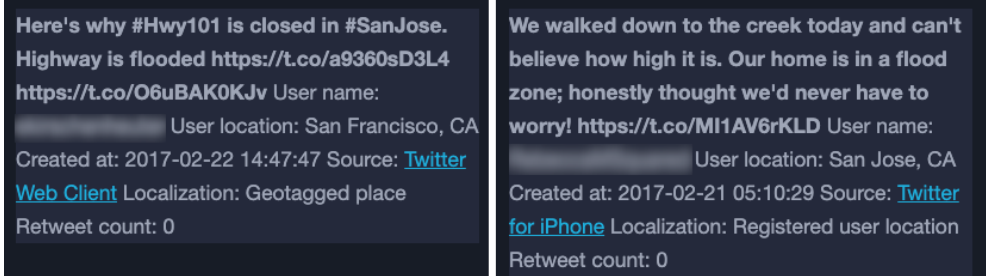
Figure 13. Hydrograph of Coyote Creek for time period 1 January–28 February 2017. Image from Cal- ifornia Nevada River Forecast Center (https://www.cnrfc.noaa.gov, accessed on 10 November 2022).